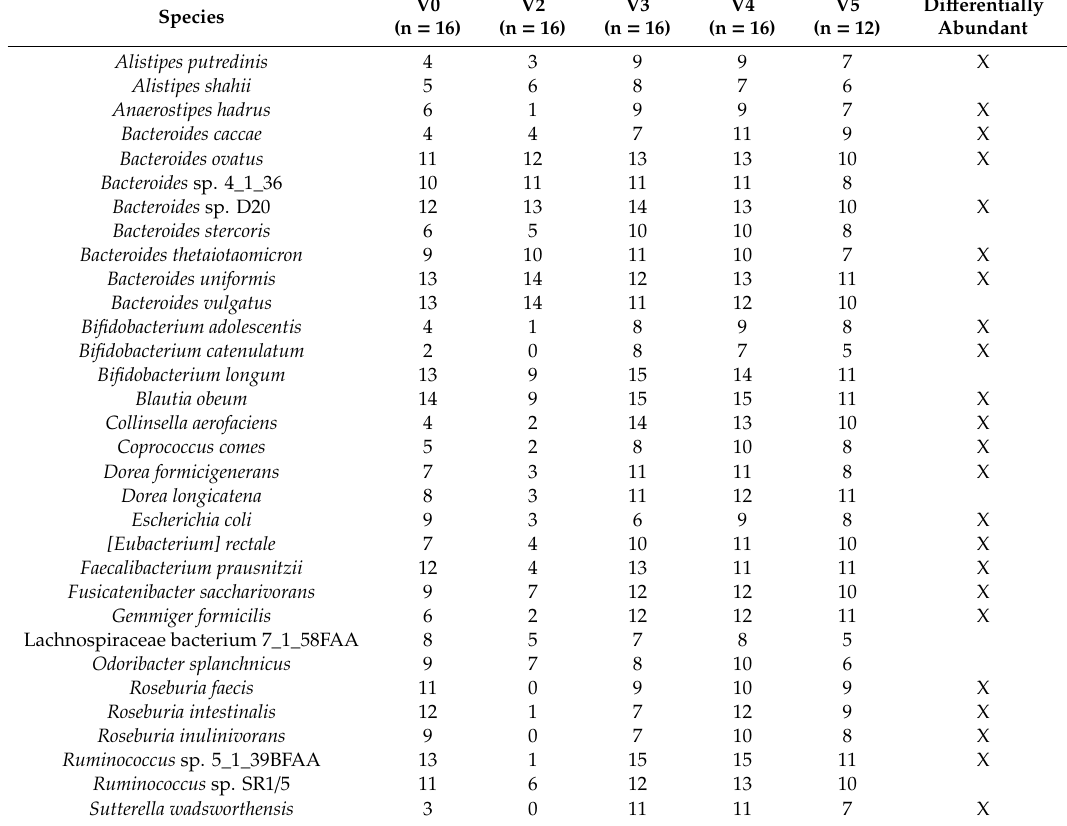
Table 1. Thirty-two species most frequently shared between the donors and the transplanted carriers. Species present in at least 8 FMT-treated carriers at V3 or at V4 are shown. For each species, numbers indicate in how many carriers they were present at a given visit. For each visit, we report the number of FMT-treated carriers analyzed (“n”). Species reported in Figure 4 are marked with an “X” in the column “Di ff erentially